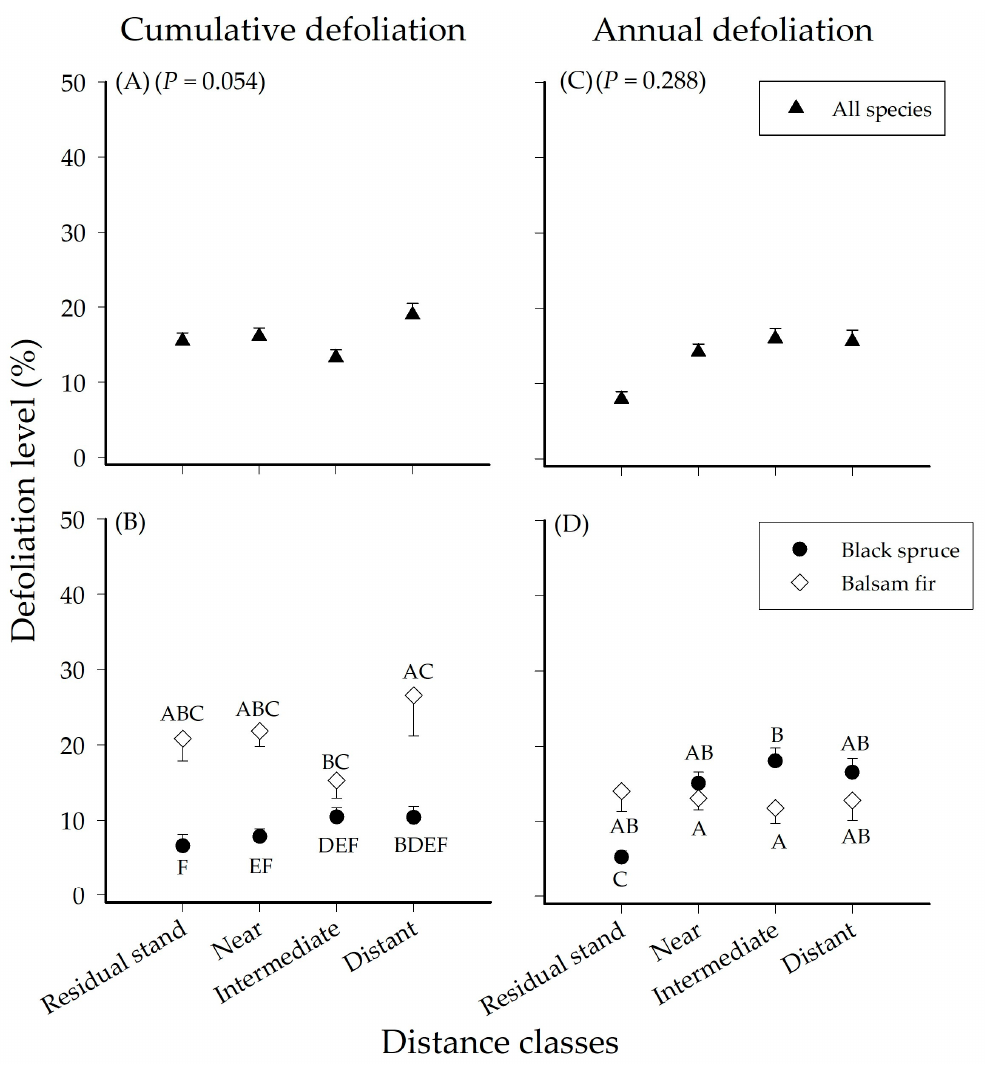
Figure 6. Cumulative defoliation (%) among distance classes for all seedlings combined ( A ) and among conifer species (balsam fir and black spruce) ( B ). Annual defoliation (%) among distance classes for all species ( C ), and among species (balsam fir and black spruce) ( D ). Vertical bars show the standard error. Di ff erent letters represent significant di ff erences between classes ( p < 0.05), following A > B > C > D > E >